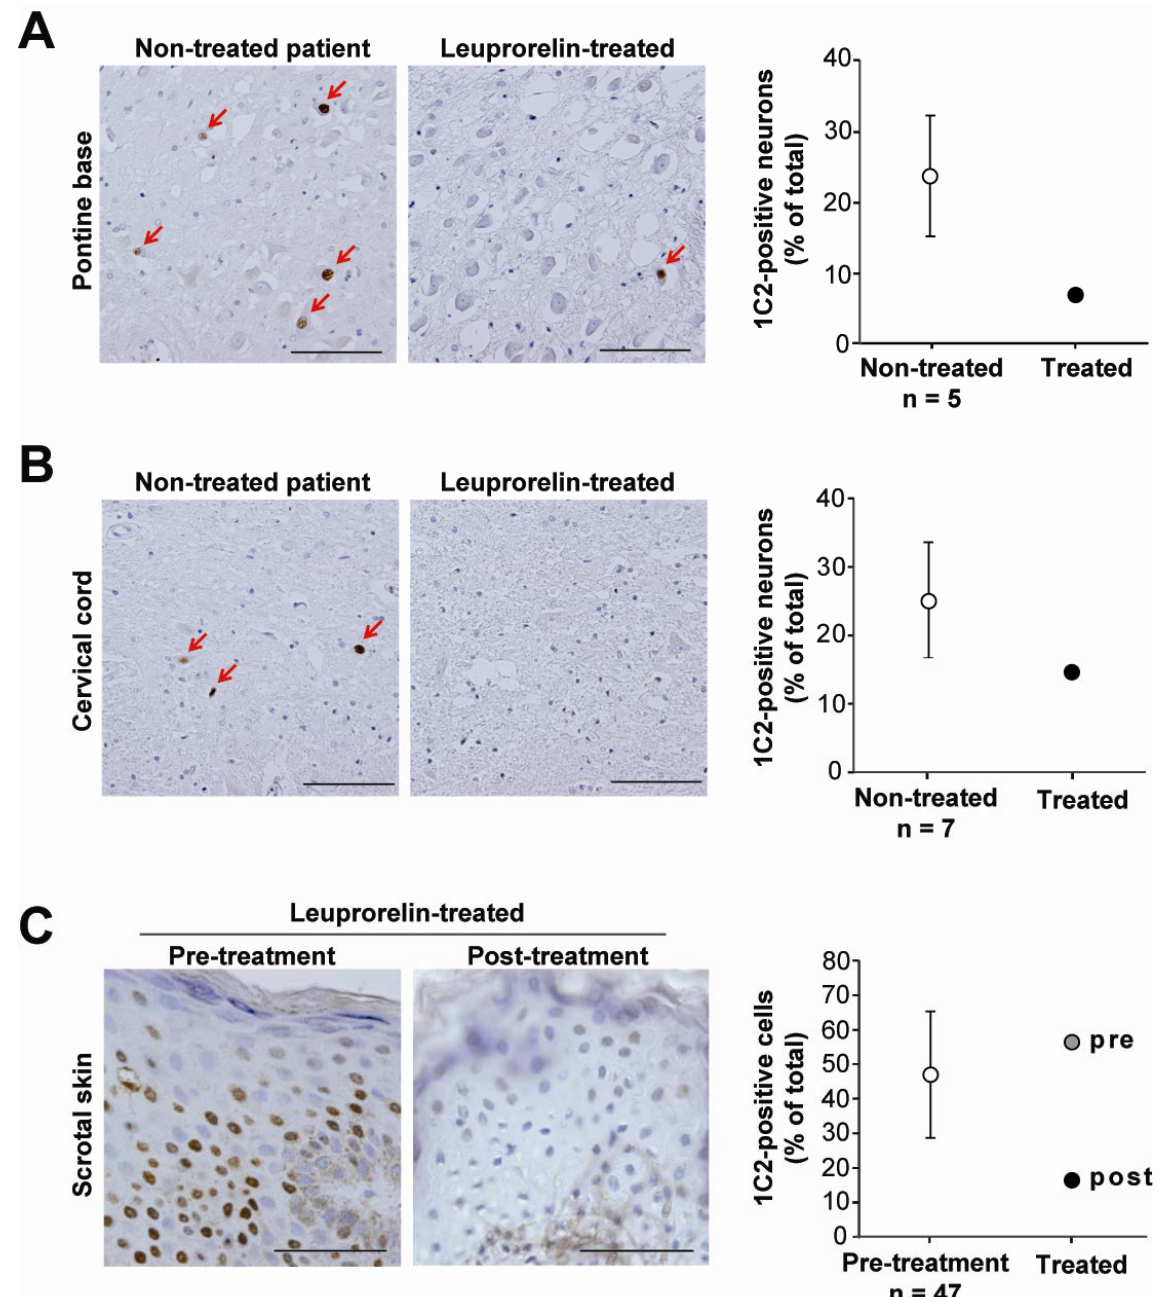
Figure 4. Effects of leuprorelin acetate on nuclear accumulation of mutant AR. (A, B) The accumulation of mutant AR in neurons was remarkable both in the pontine base and in the spinal anterior horn of all the control, non-treated autopsied patients, but the number of 1C2-positive neurons was relatively small in the leuprorelin-treated patient.